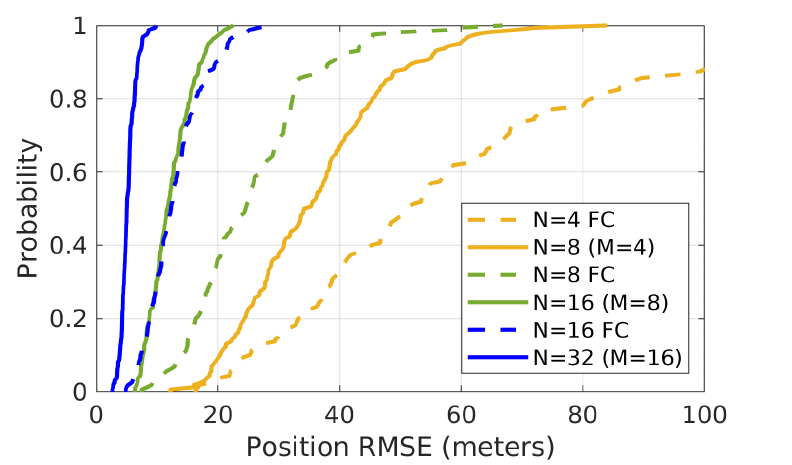
Figure 6. The CDF of each simulation’s average position error for all agents in the group for 160 Monte Carlo simulations with different algorithms and group sizes. These simulations are run with the magnetic anomaly map shown in Figure 4.